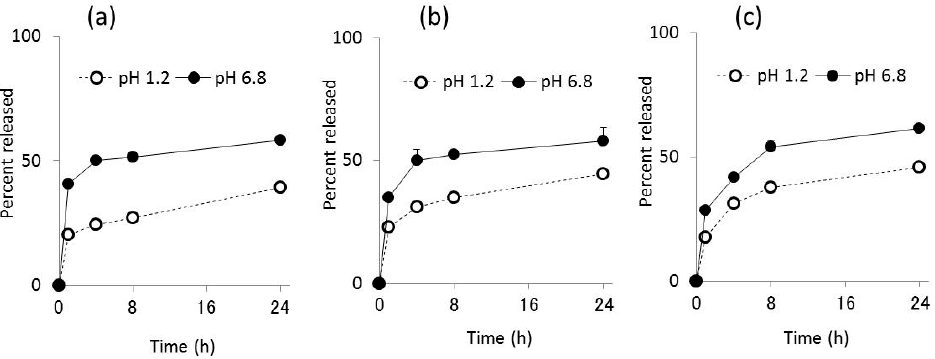
Figure 3. Release profiles of ( a ) salmon calcitonin (sCT) from Ch-TBA-MP/Eud; ( b ) Ch-TBA/TMC-MP/Eud *; and ( c ) Ch-TBA-MP/Eud. Each point represents the mean ± standard deviation (S.D.) ( n = 3). * Ch-TBA/TMC(4/1)-MP were used.